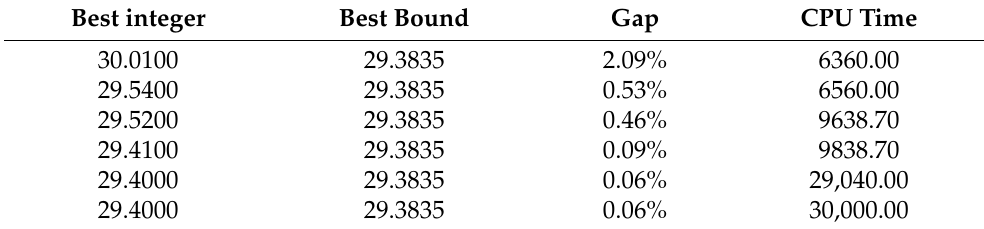
Table 6. Performance CPLEX solver—Biobio